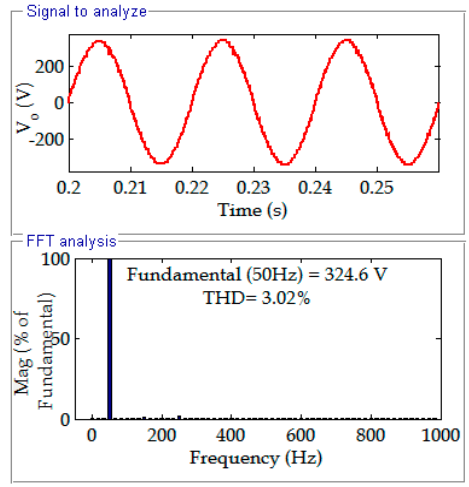
Figure 12. Harmonic spectra of 63 − level MLI.